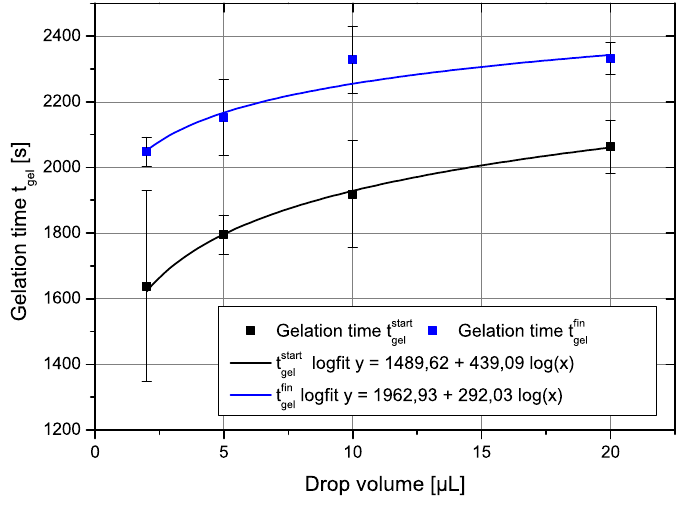
Figure 1. The two gel times defined above in the text as a function of drop volume. The drawn in curves are fit to a power law dependence on drop volume.